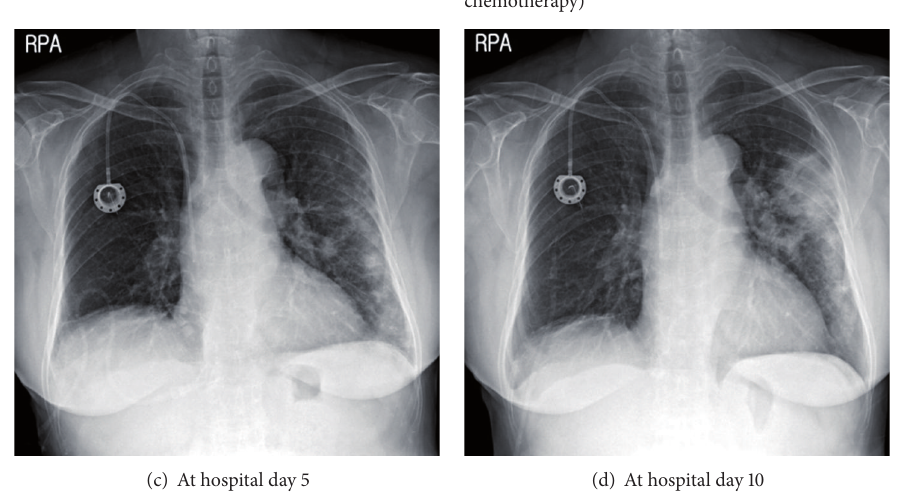
Figure 2: Serial changes in the chest X-ray during